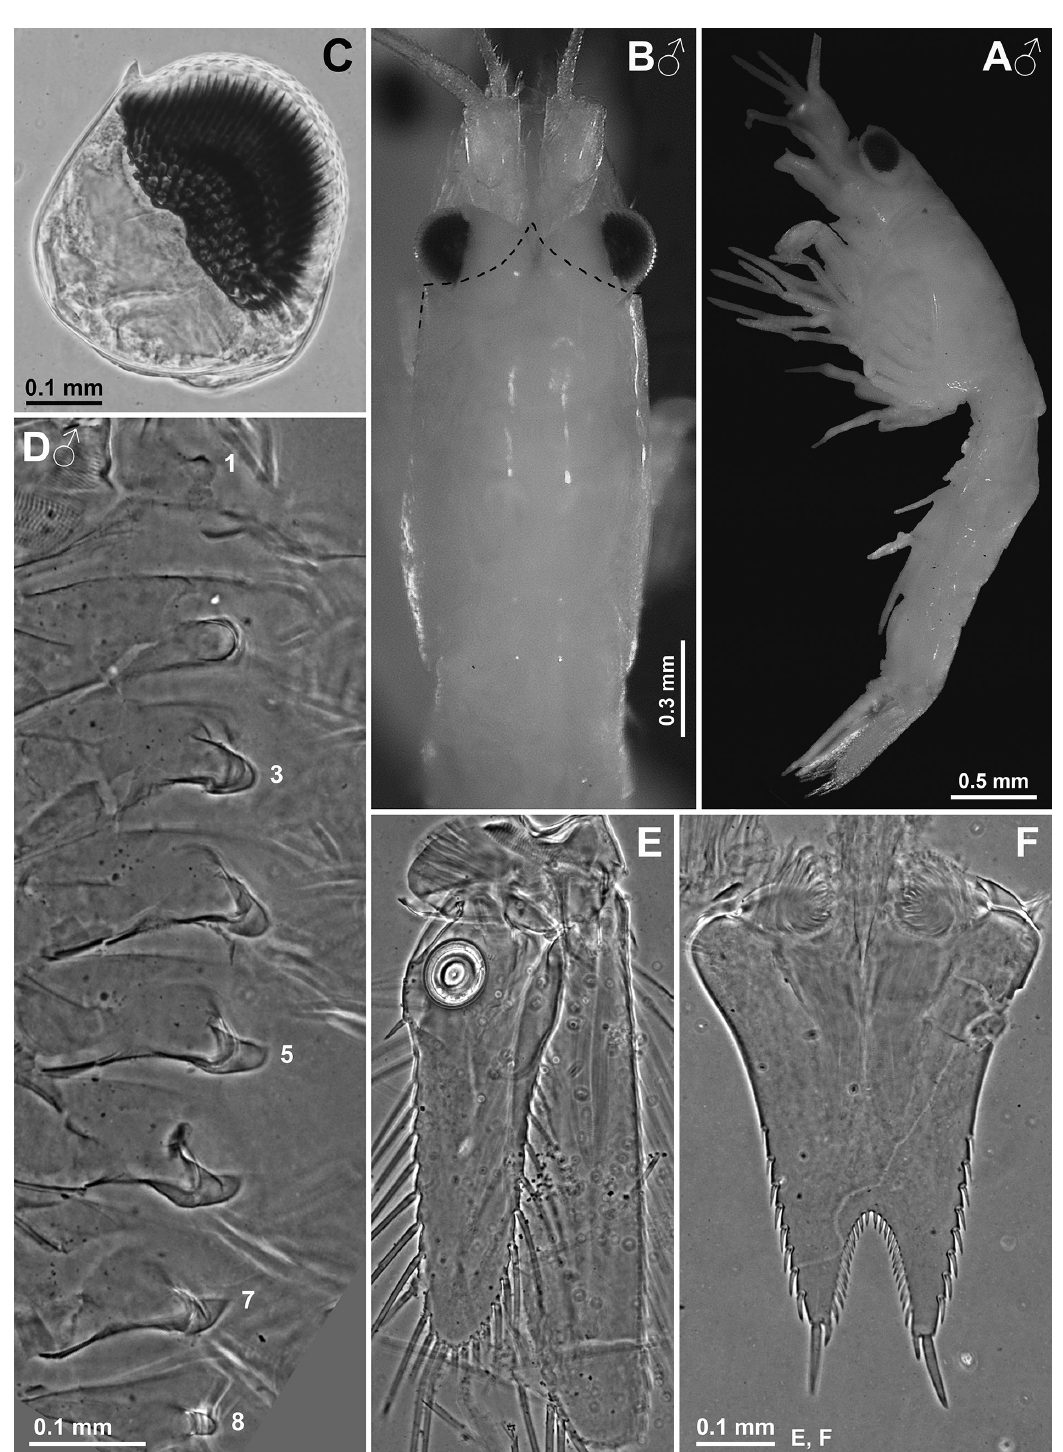
Fig. 9. Heteromysis waikikensis sp. nov., holotype, ♂ with body length 3.9 mm (A–B: NHMW 26965), paratypes, ♀ 4.2 mm (C: NHMW 26966 ) and ♂ 4.2 mm (D–F: NHMW 26967). A . ♂ in toto, lateral view; figure artificially separated from background. B . Cephalothorax, dorsal view; dashed line illustrates the anterior contour of carapace. C . Right eye, dorsal view; object somewhat compressed by cover glass pressure. D . Thoracic sternites 1–8 expanded on slide, ventral. E . Uropods, ventral. F . Telson. A–F. Ethanol-fixed materials on petri dishes (A–B) and slides